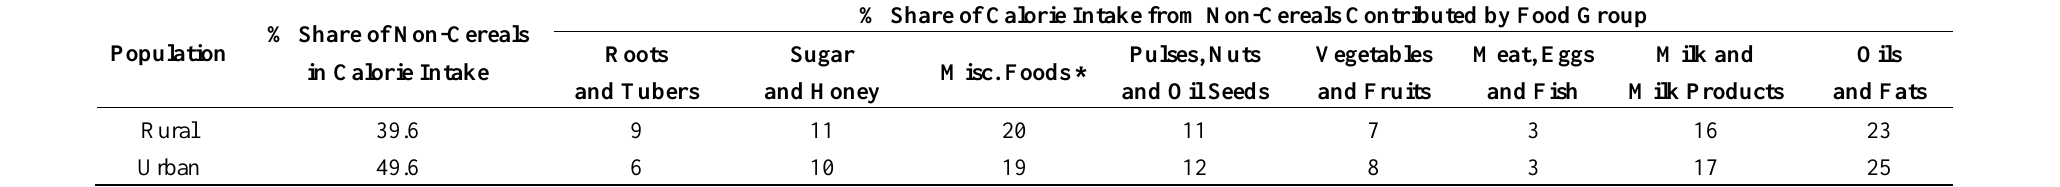
Table 4. Percentage breakdown of “sugar and honey” and miscellaneous foods: